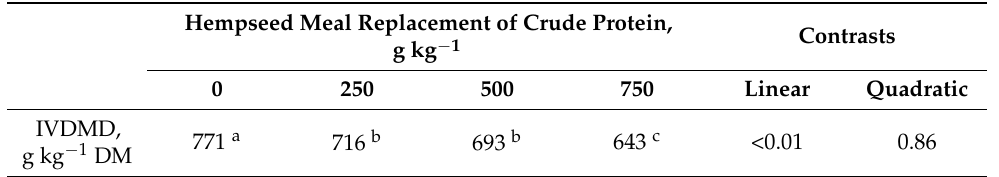
Table 4. In vitro dry matter digestibility (IVDMD) of isonitrogenous rations in which hempseed meal replaced the crude protein portion at various